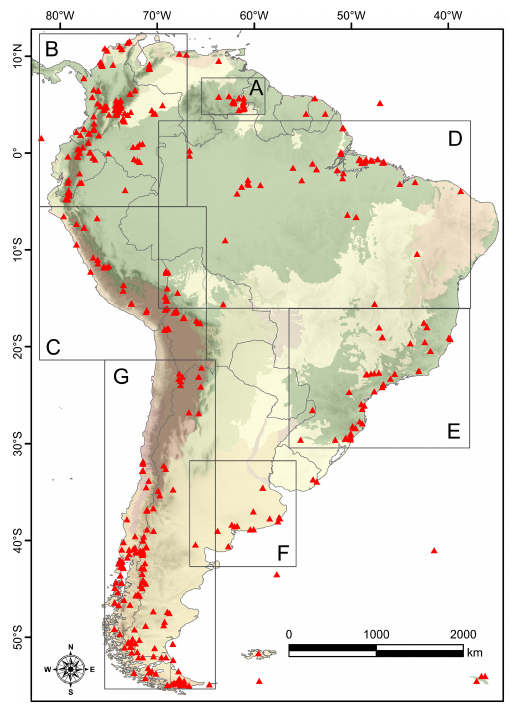
Figure 6. Map showing the location of LAPD pollen records that cover the last 2kyr (after Flantua et al., 2015). General regional delimitations as discussed in this paper are shown; A: Venezuelan Guayana highlands and uplands; B: Northern Andes; C: Central An- des; D: lowland Amazon basin; E: southern and southeastern Brazil; F: pampean plain; G: Southern Andes and